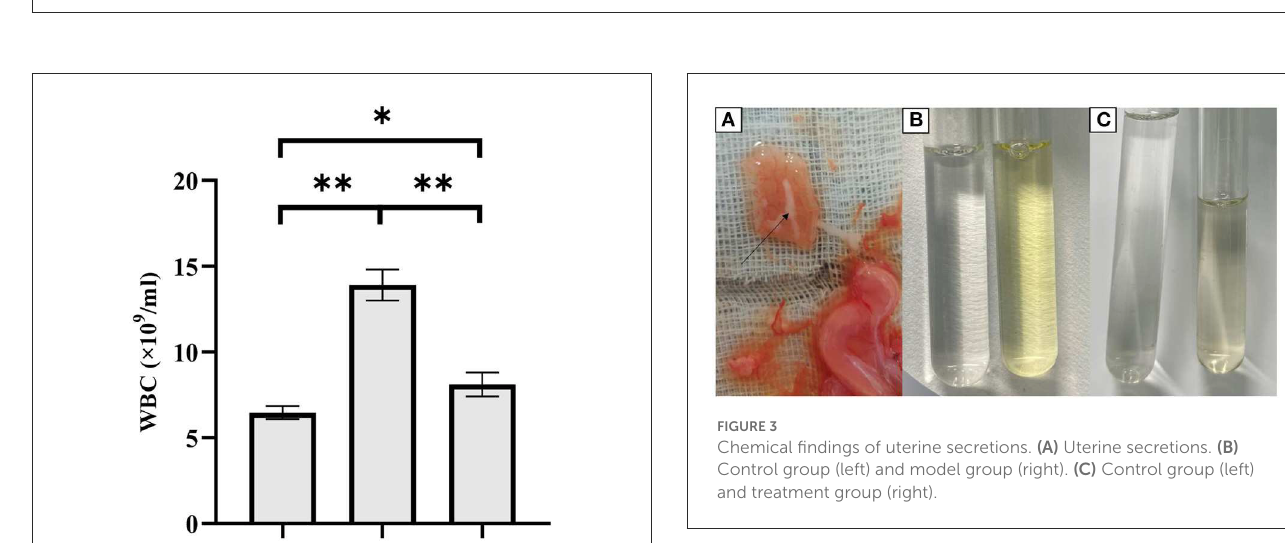
significantly higher ( P < 0.05) than the control group except for IL-6 (Figure 7).